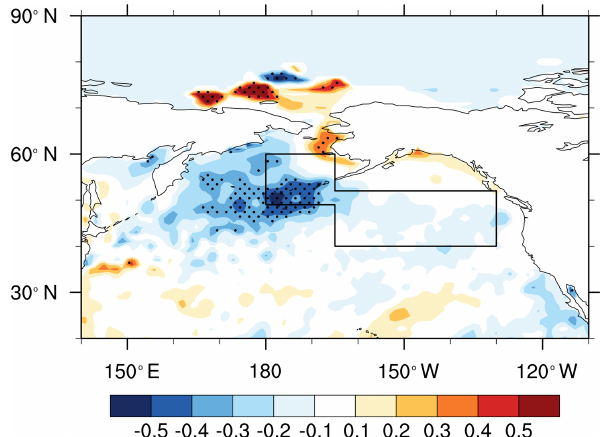
Figure 8. The CC between WSPD RS2 and SST in November from 1979 to 2015. The black dots indicate that the CCs exceeded the 95% confidence level ( t test). The black box represents the BA (Bering Sea–Gulf of Alaska). The linear trend was